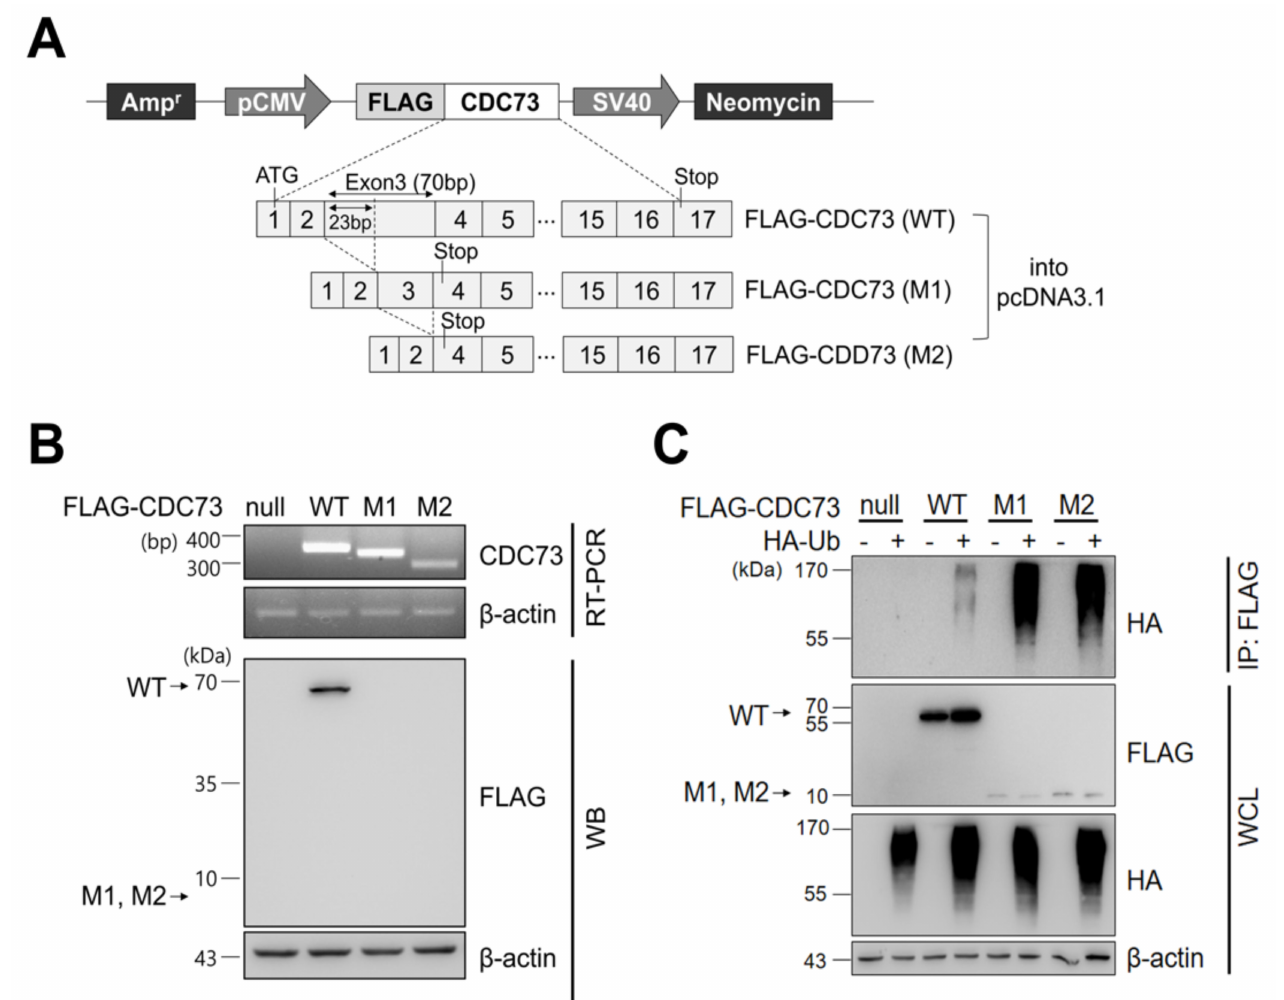
Figure 1. CDC73 expression and ubiquitination. Schematic representation of CDC73 expres- sion plasmids ( A ). For expression or immunoprecipitation (IP), full-length wild-type CDC73 and two mutant CDC73 cDNAs (23 bp and 70 bp deletions, respectively) were cloned into pcDNA3.1 vec- tor with an N-terminal FLAG tag. RT-PCR and WB results of cells transfected with CDC73 wild-type (WT) or mutant (M1, M2) expression vectors ( B ). Transcription of all three mRNAs was observed, but only the wild-type CDC73 protein was detected. To measure polyubiquitination of CDC73 ( C ), co-transfected cells were treated with 25 µ M MG132 for 4 h and IP was performed with anti-FLAG antibody. A ladder representing polyubiquitinated CDC73 can be seen in the co-transfected cells. WT, wild-type CDC73; M1, 23-bp deletion; M2, 70-bp deletion; RT-PCR, reverse transcription polymerase chain reaction; WB, western blotting; HA, hemagglutinin; Ub, ubiquitin; IP, immunoprecipitation; WCL, whole cell